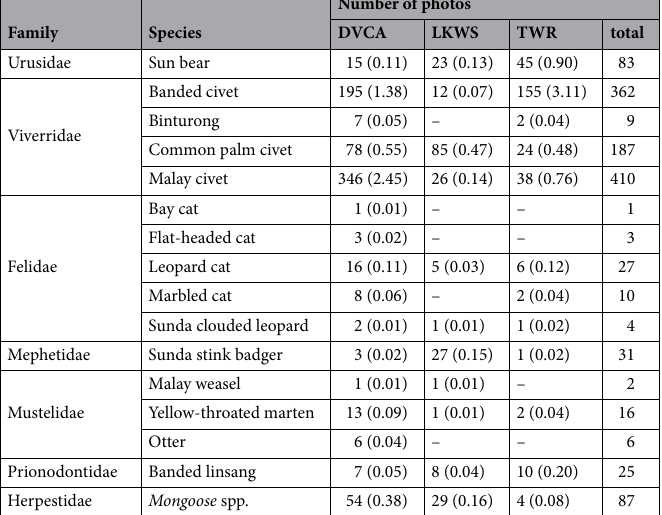
For major species that were photo-captured less than 50 times; Sunda stink badgers, leopard cats, banded linsangs, yellow-throated martens, and marbled cats, we tested the selectivity of the active period. We found that the proportion of active periods differed significantly in all five species ( χ 2 = 109.0, p < 0.01 in Sunda stink badgers; χ 2 = 4.92, p < 0.01 in leopard cats; χ 2 = 78.0, p < 0.01, in banded linsangs; χ 2 = 6.10, p < 0.01 in yellow- throated martens; χ 2 = 4.44, p < 0.01 in marbled cats). Sunda stink badgers, leopard cats, and banded linsangs used nighttime more than expected (p < 0.01) and less than expected during day time (p < 0.01) and twilight (p < 0.01) (Table 2). Yellow-throated martens used daytime more than expected (p < 0.01) and nighttime less than expected (p < 0.01), and there were no significant differences in the usage between daytime and twilight (p = 0.28) (Table 2). Marbled cats used daytime more than expected (p < 0.01) and less than expected at nighttime (p < 0.01) and twilight (p < 0.01) (Table 2). From these data, we determined that Malay civets, banded civets, common palm civets, Sunda stink badg- ers, leopard cats, and banded linsangs were strongly nocturnal (Fig. 2). Marbled cats were strongly diurnal, and yellow-throated martens were diurnal and crepuscular (Fig. 2). Note that these species were also active during twilight, so the activity pattern here indicates their tendency. The sun bears were cathemeral (Fig. 2). Temporal activity overlaps among the carnivore species. The temporal activity overlaps among the analyzed carnivore species are generally high (0.74 ≤ Δ 1 or Δ 4 ) among the nocturnal species (banded civets, com- mon palm civets, Malay civets, Sunda stink badgers, leopard cats), except for banded linsangs, showing moderate values among these species (Δ 1 < 0.7) (Table 3). Contrary to the nocturnal species, the overlap between diurnal species (marbled cats, yellow-throated martens) was moderate (0.6 < Δ 1 ) (Table 3). We found the highest activity overlap between common palm civets and Malay civets (Δ 4 = 0.95). The level of activity overlaps among species in the same family varied among the taxa; those of civets were highly overlapped (0.85 ≤ Δ 4 ), while that of felids (Δ 1 = 0.41) was low (Table 3, Fig. 3).